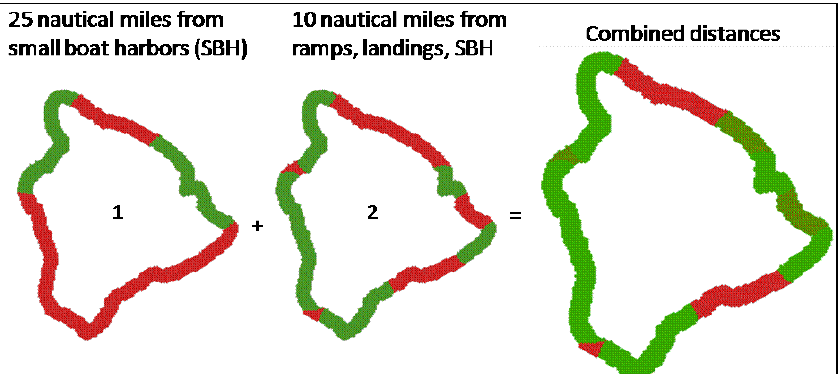
Figure 1. Accessibility of possible nearshore aquaculture sites by boats. Green areas depict sites accessible by boat and red are inaccessible based on the distance